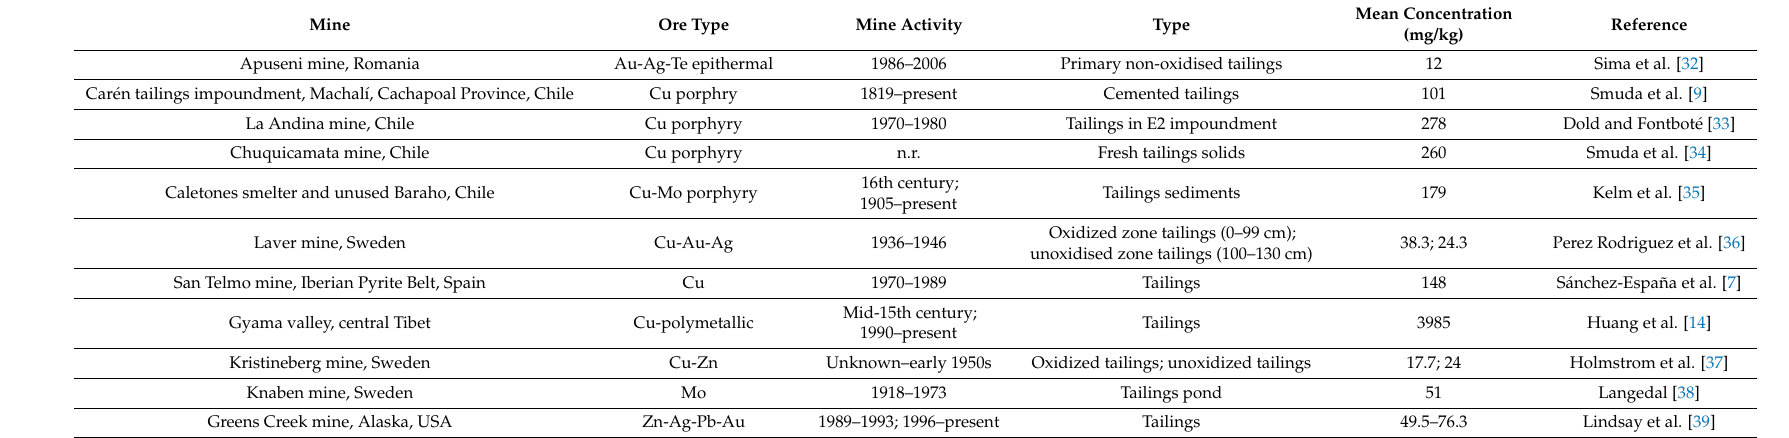
Table 2. Concentrations of Mo in mine tailings. n.r.: not reported.